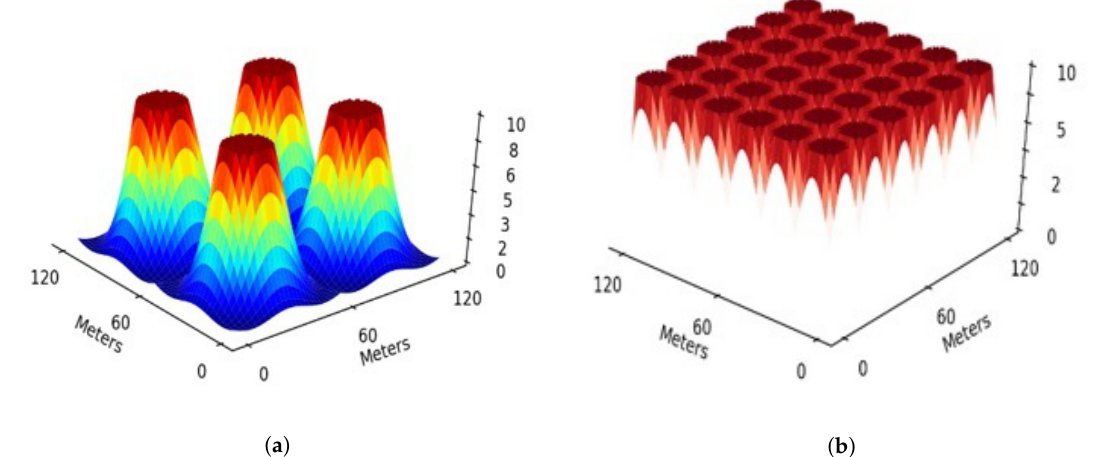
Figure 6. Spectral efficiency of 6G, ( a ) Spectral efficiency;10 is the peak efficiency, x and y axes shows area in meter, and ( b ) Efficiency using multiple access points of